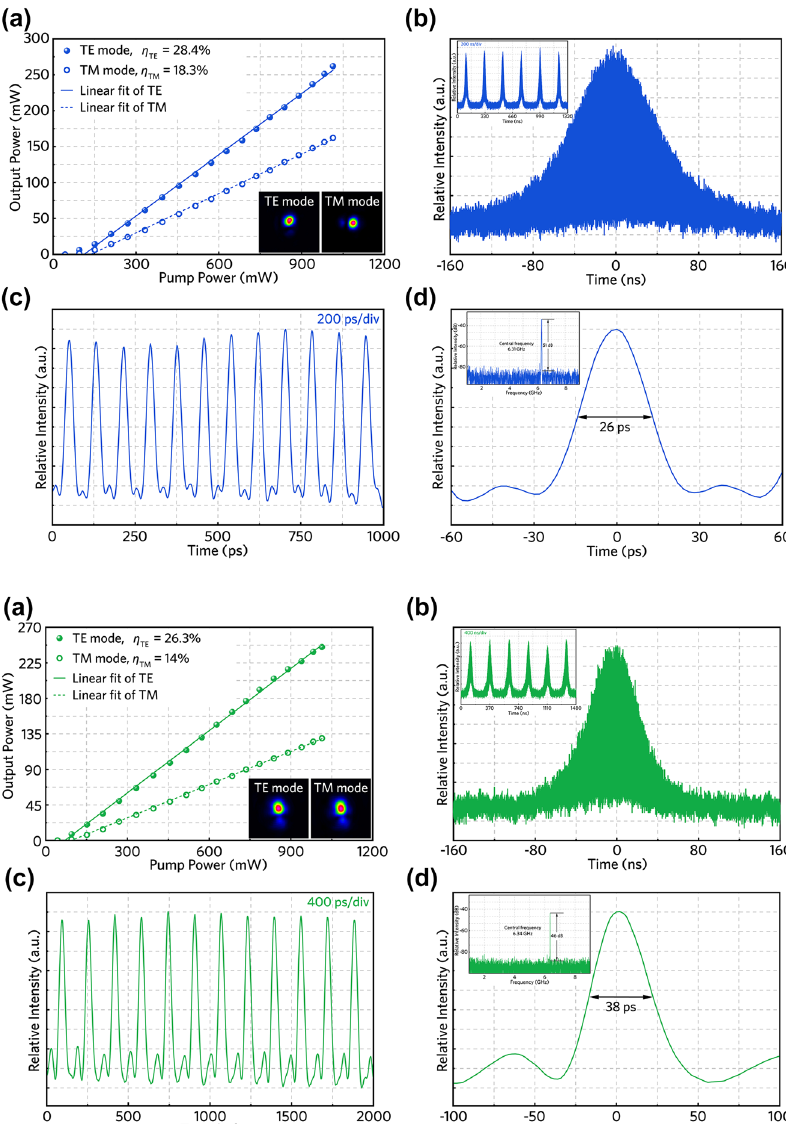
Figure 8: ZrSe locked